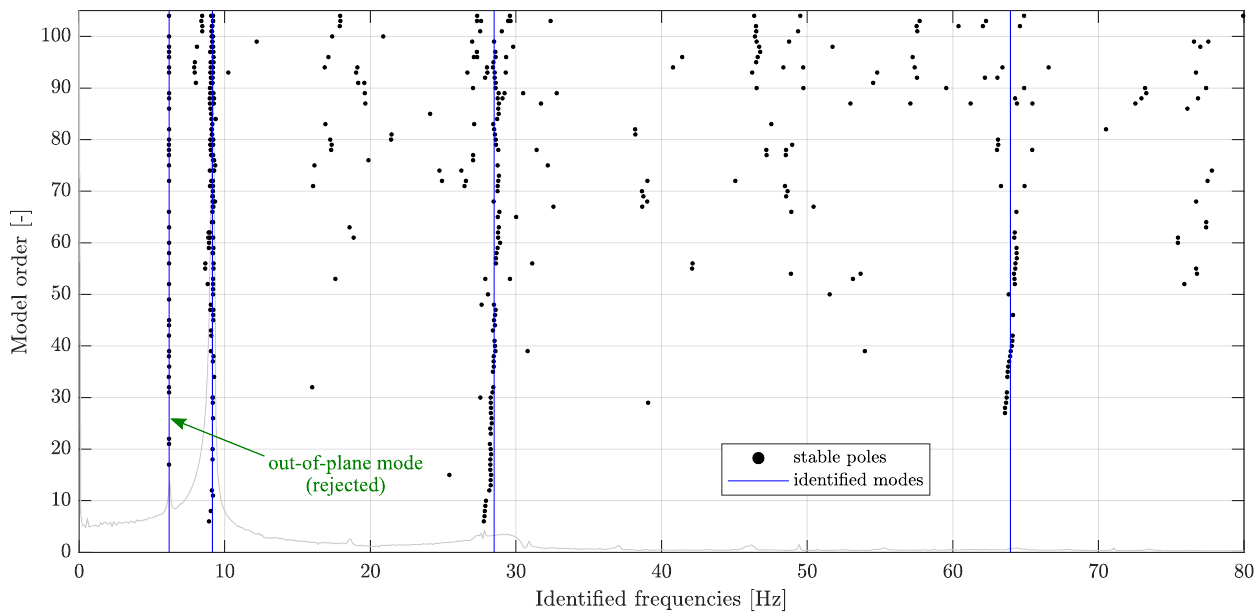
Figure 11. Stabilization diagram with the identified modes, including one rejected out-of-plane mode, as obtained in the fourth video.